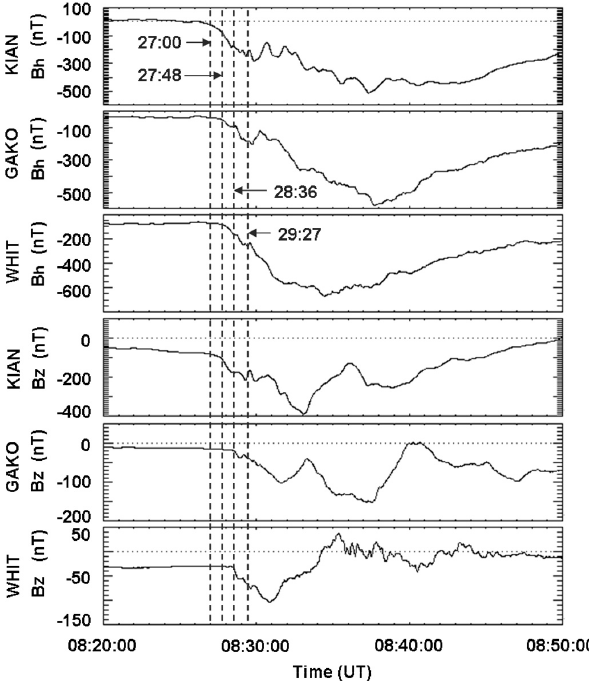
Fig. 7. The H-component and Z-component of 1-s resolution mag- netic field (relative to the background dipole field) measured at mag- netometer sites from west to east at KIAN, GAKO, and